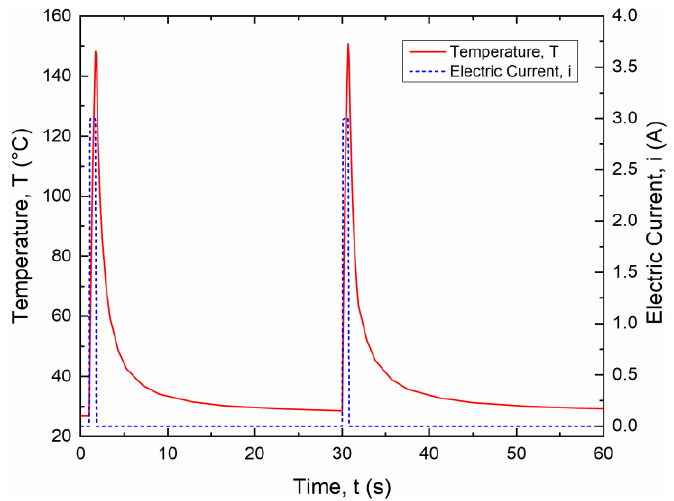
Figure 15. Time evolution of the temperature in the SMA wire for two subsequent thermal activation cycles (current — 3 A, pulse time — 0.75 s, period — 30 s) as obtained from FE simulations. Maximum temperature (around 145 °C) is almost the same as the one measured by